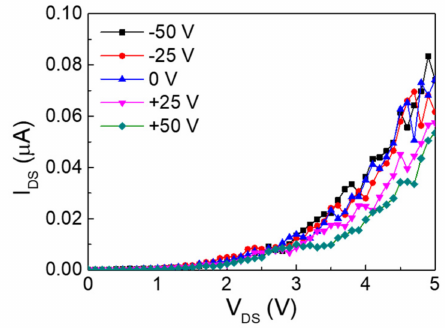
Figure 3. I DS -V DS measurements of the OG-20 as a function of gate-bias